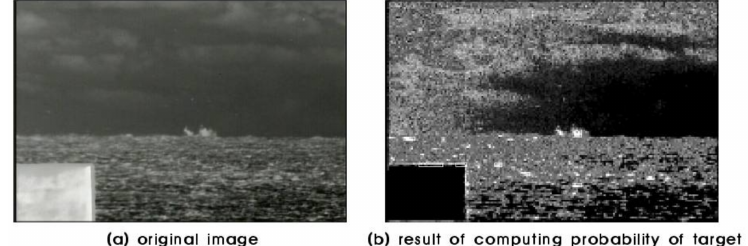
Figure 14. Result of screening target